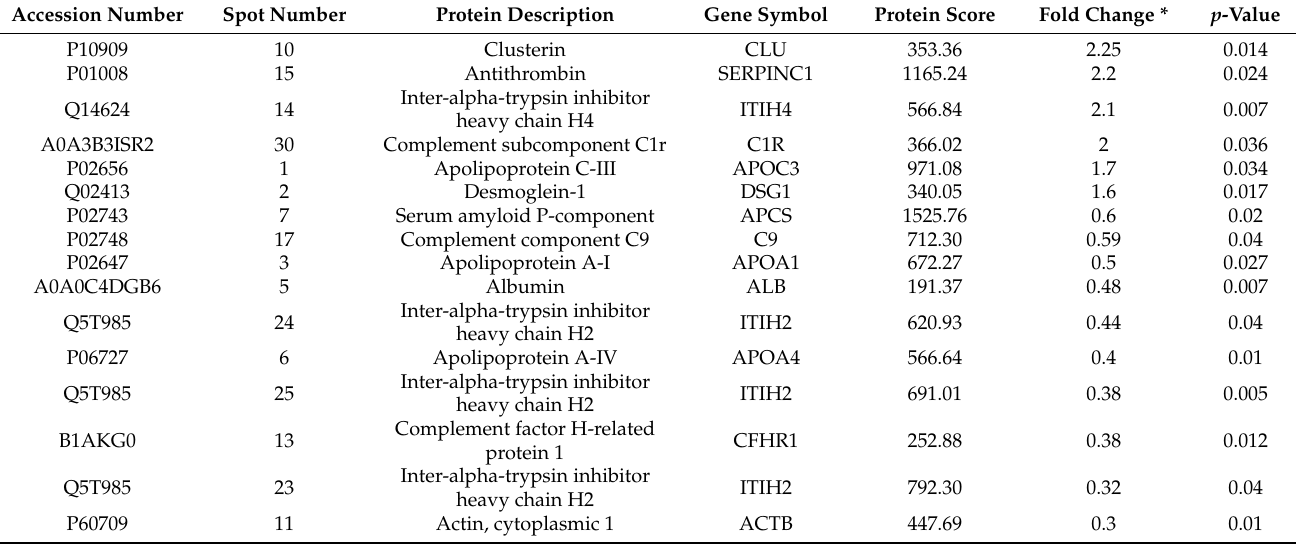
Table 1. Different abundance proteins identified by mass spectrometry in EC compared to the control serum.